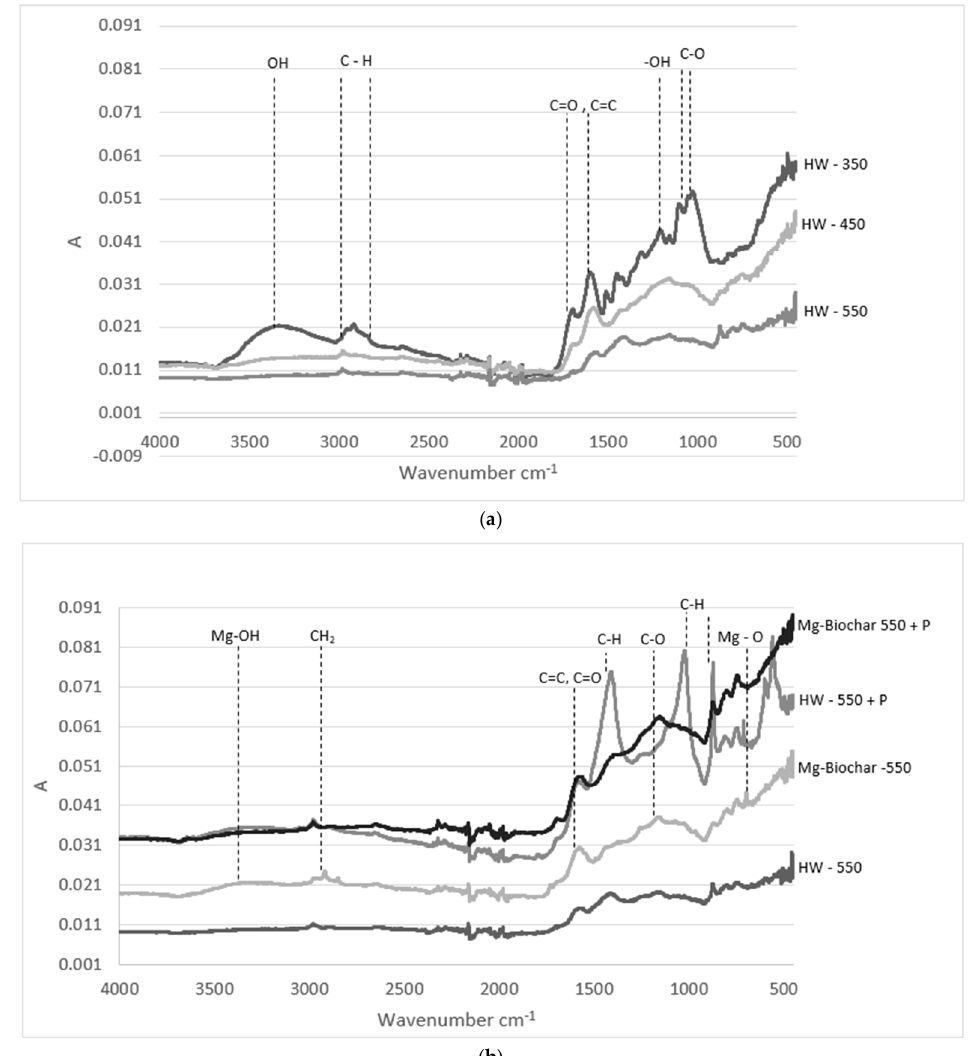
Figure 4. Fourier-transform infrared spectroscopy: ( a ) biochars prepared at different pyrolysis temperatures; and ( b ) modified and unmodified biochar before and after P adsorption.